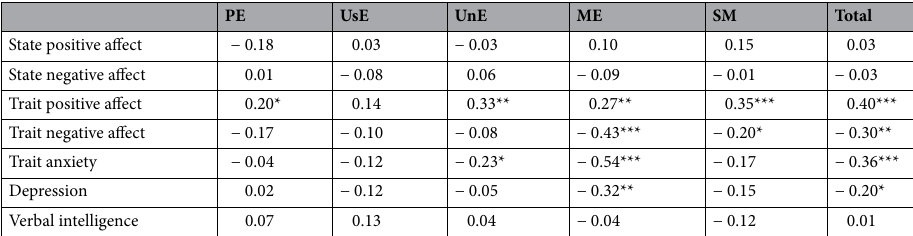
Table 1. Correlations of SREIS scales with state and trait affectivity (PANAS), trait anxiety (STAI), depression (BDI-II), and verbal intelligence (MWT-B) (N = 104). PE, perceiving emotion; UsE, use of emotion; UnE, understanding emotion; ME, managing emotion (self); SM, social management. * p < 0.05, ** p < 0.01, *** p <